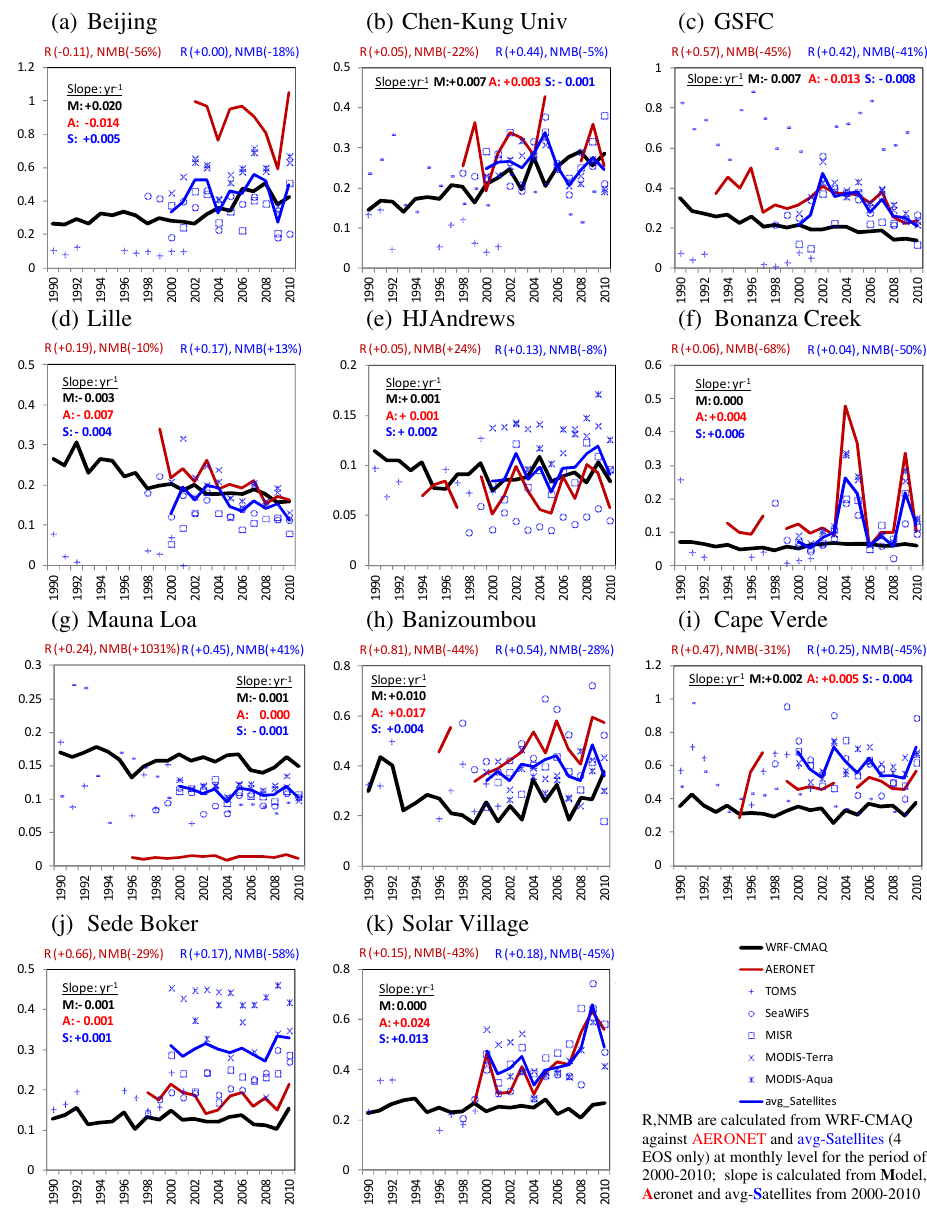
Figure 5. Comparison of JJA-averaged AOD of selected AERONET sites.